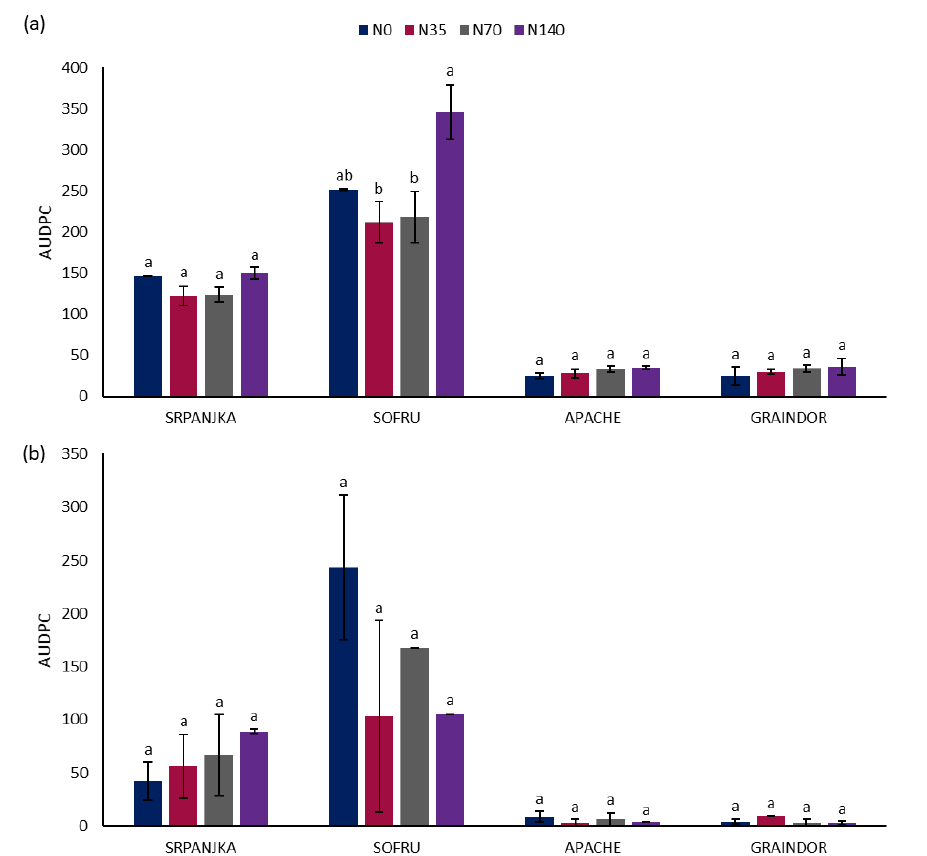
Figure 1. The area under the disease progress curve (AUDPC) for general FHB resistance in 2018/2019 ( a ) and 2019/2020 ( b ). Values are means of two replicates ± standard error (SE). Different letters above the bars indicate significant differences according to Fisher’s LSD test ( p ≤ 0.05) among different nitrogen levels in each variety separately.